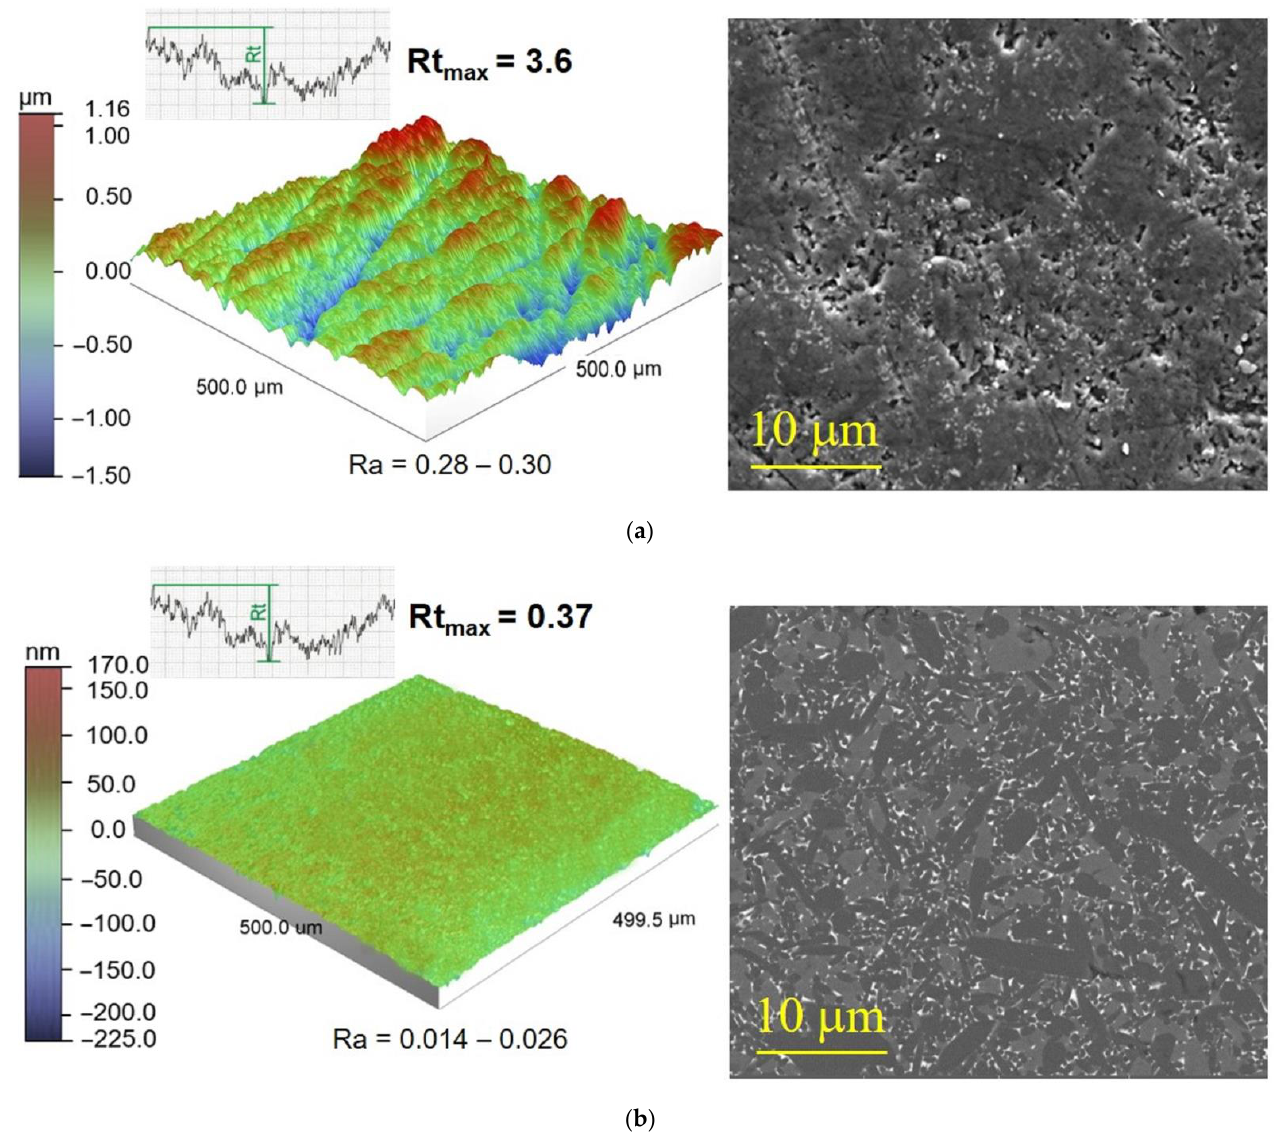
Figure 6. 3D profilograms (left) and SEM images (right) of the microstructure of the surface layer of SiAlON ceramic inserts after diamond grinding ( a ), and after diamond grinding, lapping, and polishing ( b ).